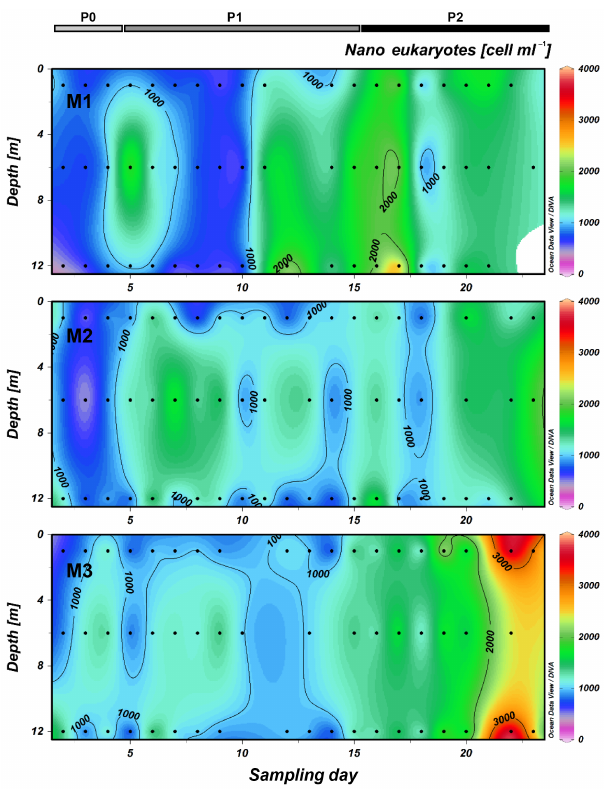
Figure 8. Diatom genera/species abundance in cellsL − 1 at the in- Figure 8 : Diatom genera/species abundance in cells L -1 at the intermediate depth (6 m) in each mesocosm. termediate depth (6m) in each